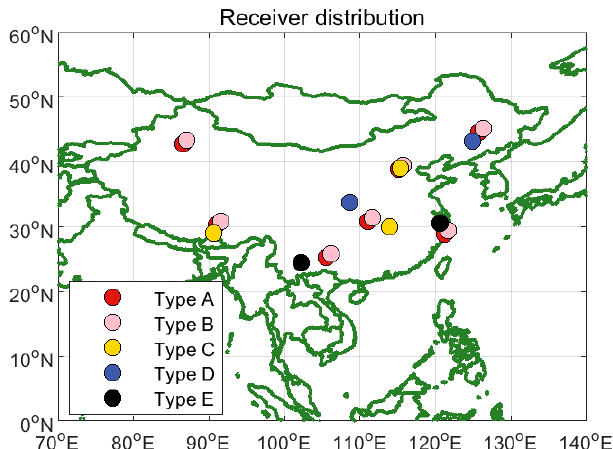
Figure 8. Receiver distribution.